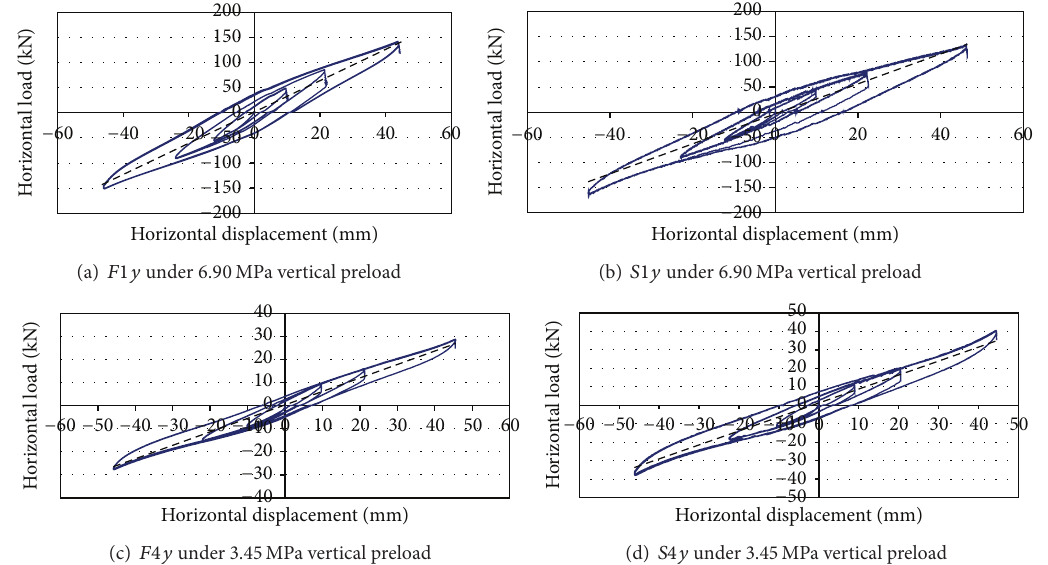
Figure 7: Horizontal shear test results for some of the specimens (horizontal load versus horizontal displacement for a pair of bearings).